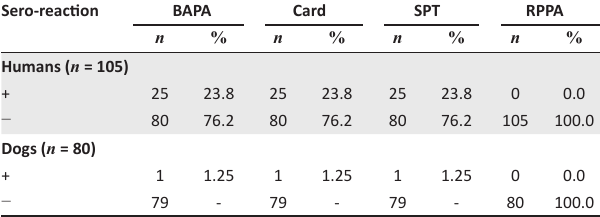
TABLE 1: Sero-reactions to brucellosis tests for human and canine blood samples tested between January and June 2014 in Kampala, Uganda. Sero-reaction